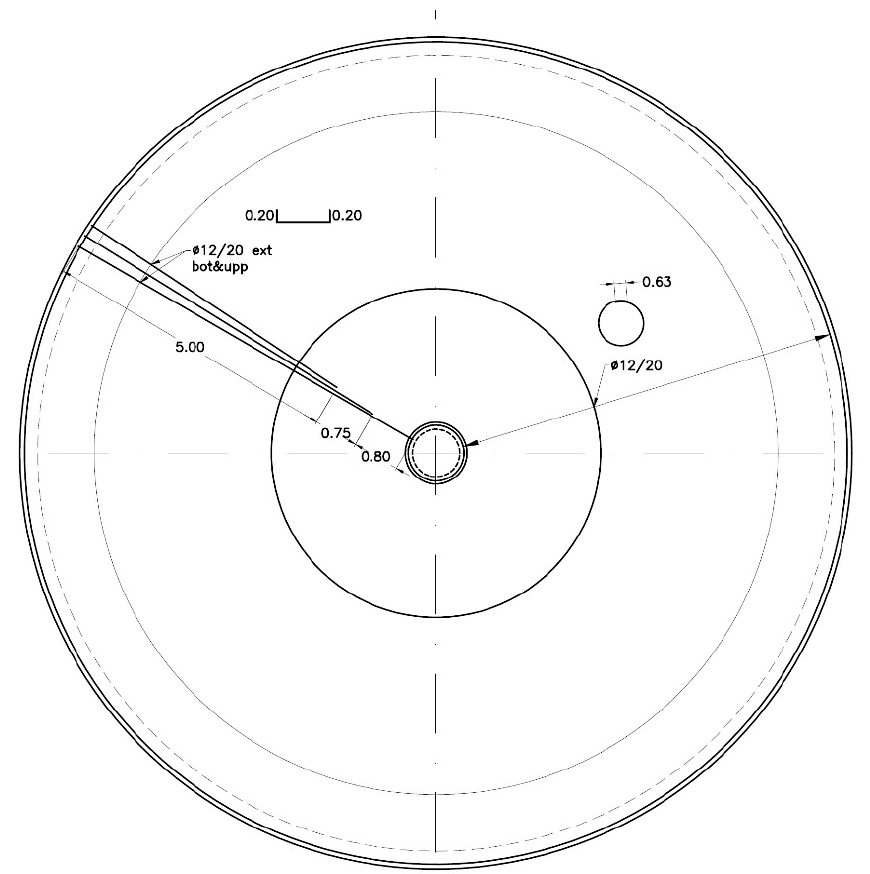
Figure 4. Reinforcement plan view of the top slab of the reservoir.